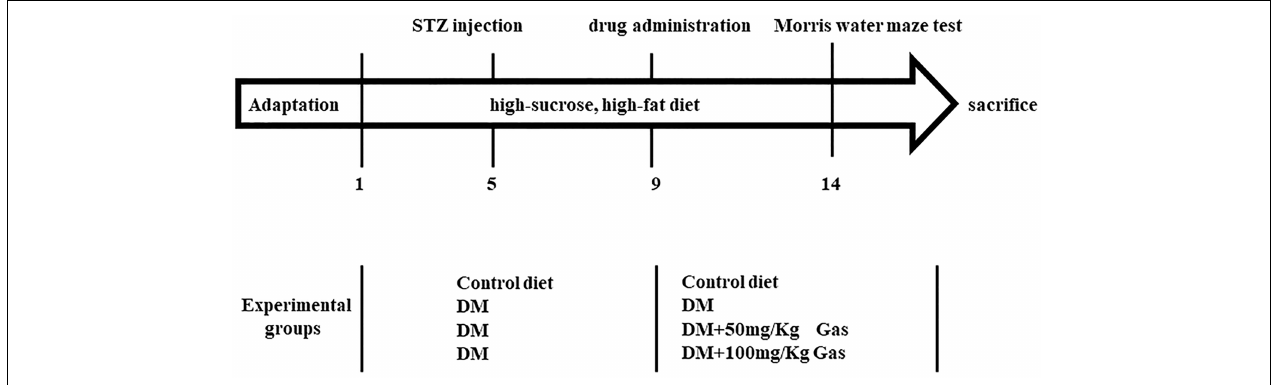
FIGURE 2 | Summary of the experimental